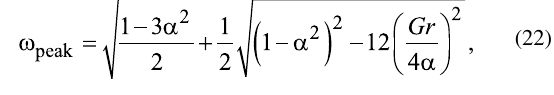
We can see that they are close to each other, which proves the correctness of the chosen approximation. Both curves demon- strate an asymmetric resonance peak, which is common for a Duffing oscillator. When the role of the cubic term is getting larger, we observe a bistability of the resonance curve, which is usually called a fold-over effect. Note that the fold-over effect can be also achieved by decreasing the damping. This means that, by decreasing the dissipative term in Equation 18, we can increase the influence of the cubic term in this equation.